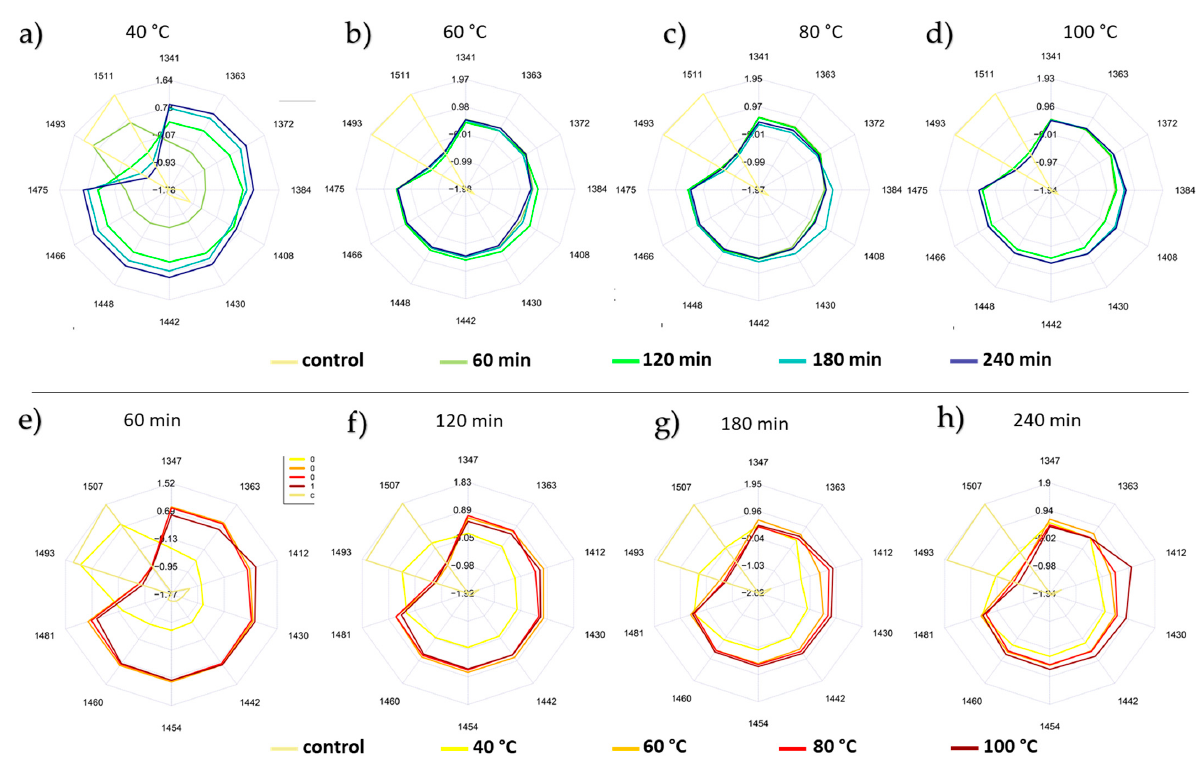
Figure 5. Aquagrams of the bastard indigo honey: ( a – d ) aquagrams showing pattern of time intervals; ( e – h ) aquagrams showing the pattern of temperature levels.